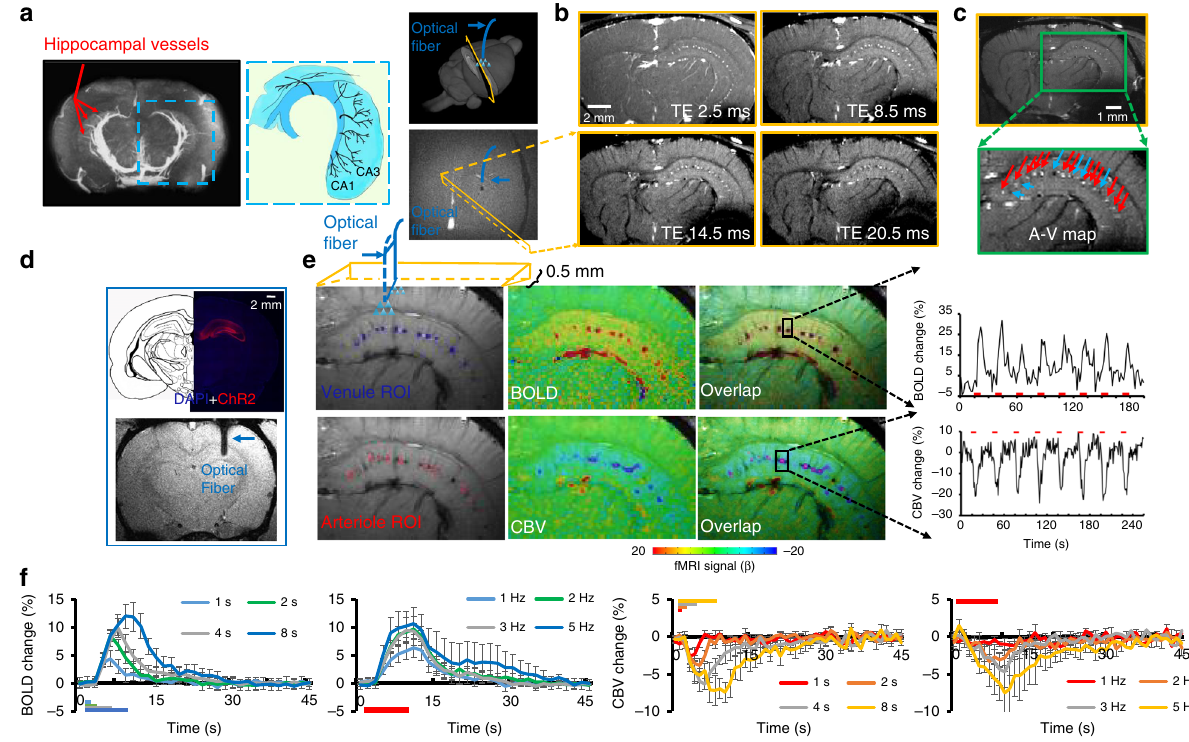
Fig. 2 Single-vessel hippocampal BOLD and CBV-weighted fMRI. a The magnetic resonance angiography (MRA) image shows major vascular branches penetrating the rat hippocampus (middle image is the schematic drawing of the hippocampal transverse plane of vessels aligned in parallel [modi fi ed from Peter Coyle (1976)]). The 3D view of the 2D slice alignment to cover the transverse hippocampal structure (lower image is the horizontal view to show the 2D slice with 40° to the midline to cross the penetrating vessels, dark hole: the fi ber optic tip). b Representative images of 2D MGE slices from the hippocampus at different TEs. c A – V map derived from images in b . Arterioles and venules appear as bright and dark dots, respectively [zoomed view of hippocampal arterioles (bright dots, red arrows) and venules (dark dots, blue arrows)]. d A histological section shows ChR2 expressed in the hippocampus (upper). The T2*-weighted (T2*-W) image shows the optical fi ber inserted into the hippocampus (lower, blue arrow). e Venule (blue)/arteriole (red) ROIs on A – V maps (left). Evoked BOLD (upper) and CBV-weighted (lower) fMRI maps on the same 2D slice (center) and overlap (active voxels are in purple in overlap images). Time courses of the evoked BOLD and CBV-weighted fMRI with the block-design paradigm from a representative venule (upper) and arteriole (lower) ROI (illumination: 10 ms light pulse, 3 Hz, 4 s, 5 mW). f Averaged BOLD (upper) and CBV-weighted (lower) fMRI responses from different stimulation durations (1, 2, 4, and 8 s) and frequencies (1, 2, 3, and 5 Hz) ( n = 4, mean ±